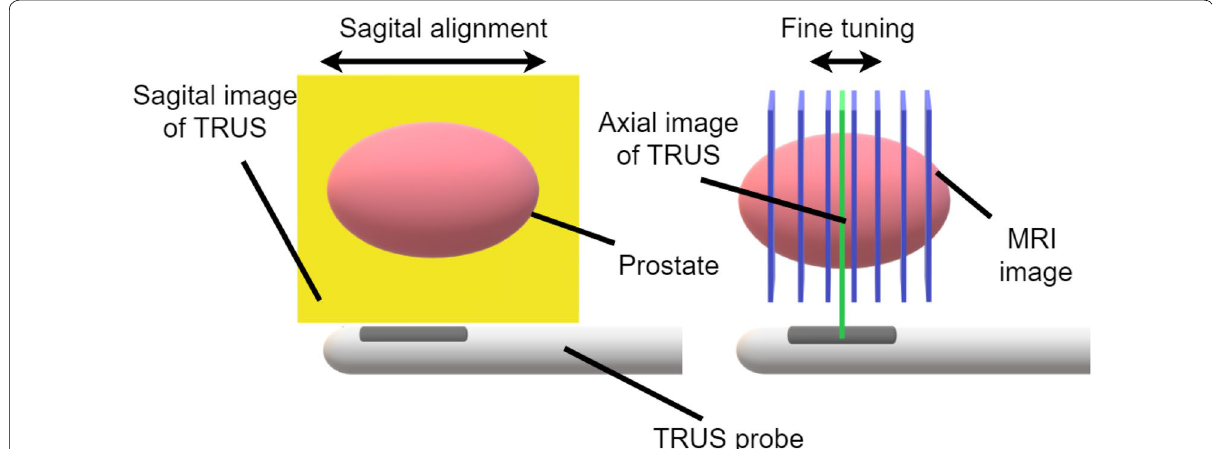
Fig. 1 The procedure for sagittal alignment in an MR-TRUS fusion biopsy. After aligning on the sagittal image, fine adjustment is performed on the axial